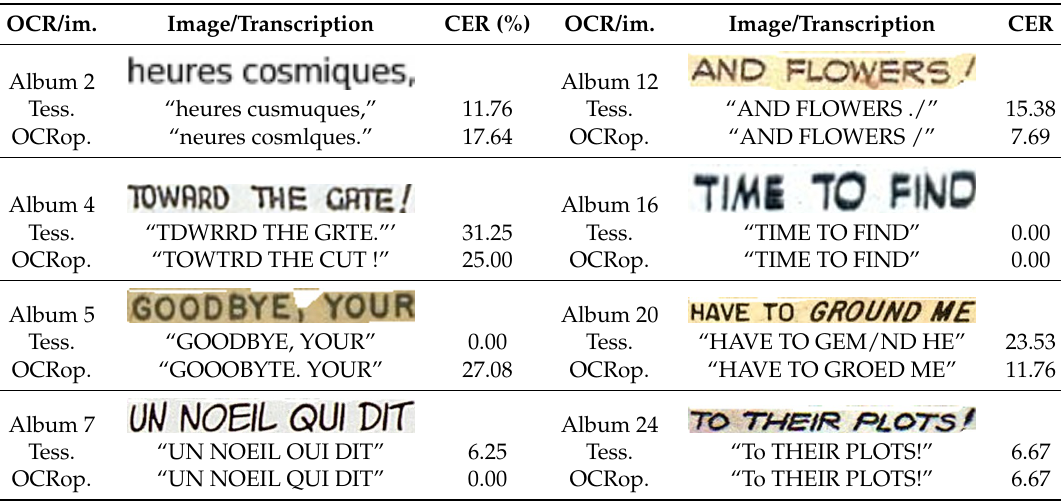
Table 2. Image examples for some albums from eBDtheque and DCM772 datasets. OCR transcriptions are written between double quotes below text line images for the two OCR systems (Tesseract and OCRopus), with corresponding Character Error Rate (CER). OCRopus transcriptions are given for the best trained model between 10,000 and 50,000 iterations. Image credits: eBDtheque dataset [88] and public